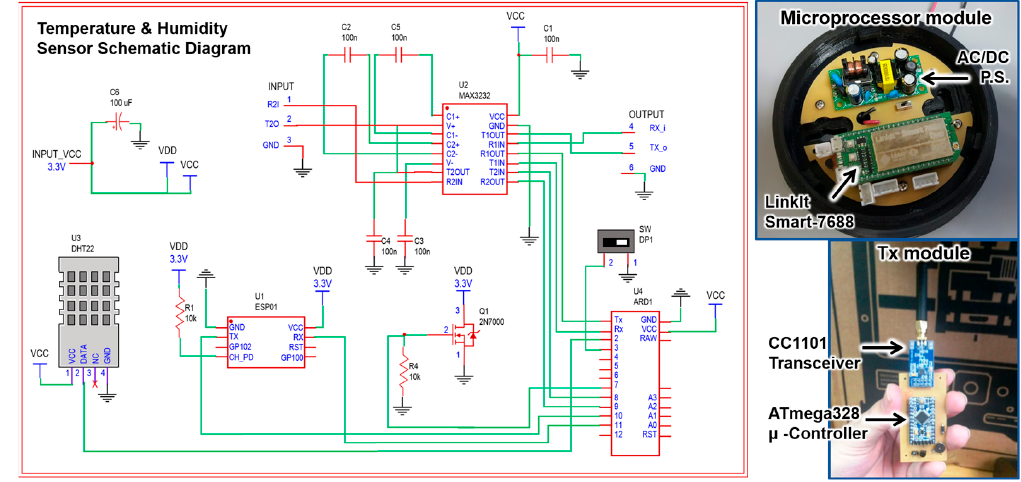
Figure 3. Design, electronic components, and model blueprint [57].